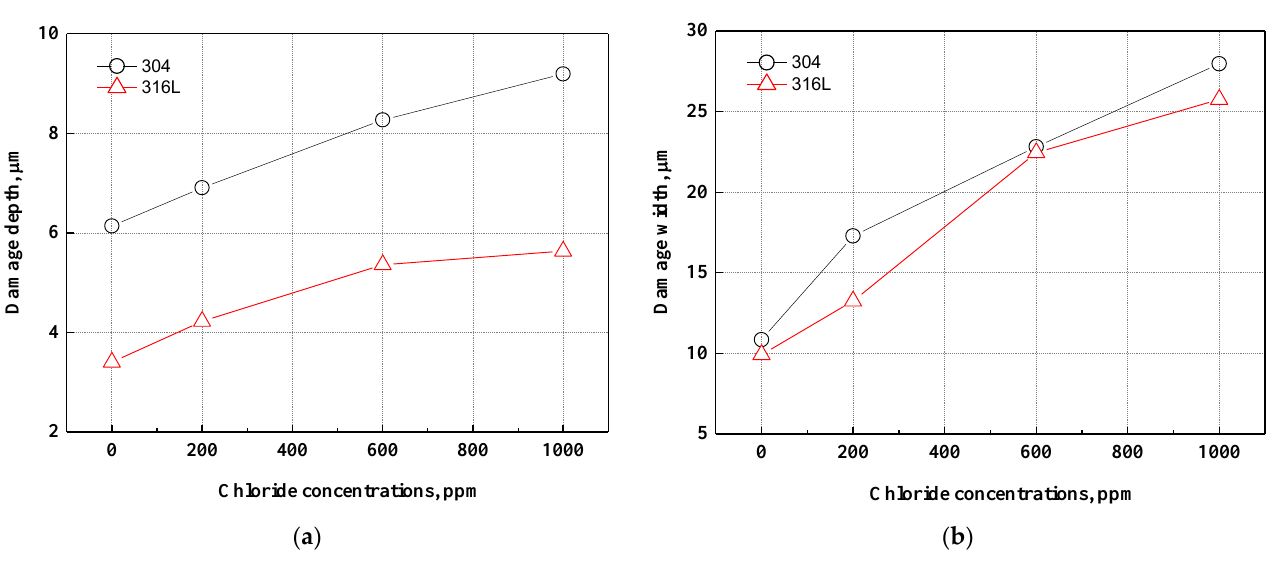
Figure 10. Comparison of damage depth and width of damaged surface for 304 and 316L stainless steels after a potentiodynamic polarization experiment: ( a ) damage depth; ( b ) damage width.